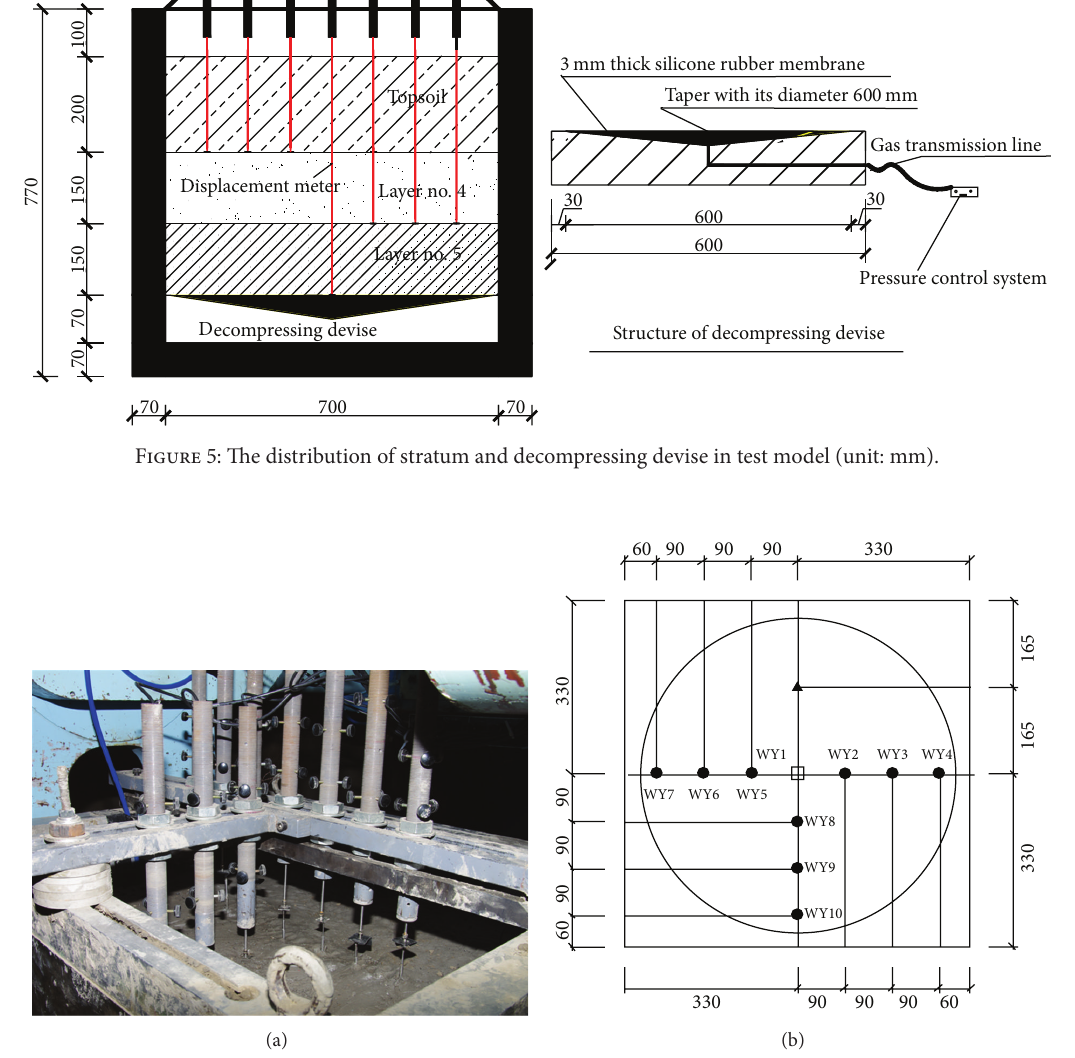
Figure 6: The distribution of displacement meters (unit: